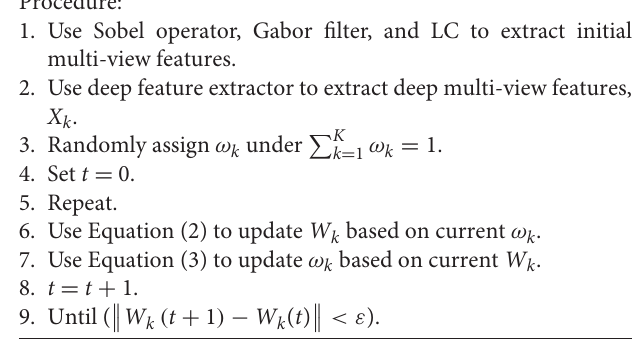
FIGURE 3 | An example of original multi-view features. (A) Original pattern, (B) Feature map of shape, (C) Feature map of texture, and (D) Feature map of salient region.